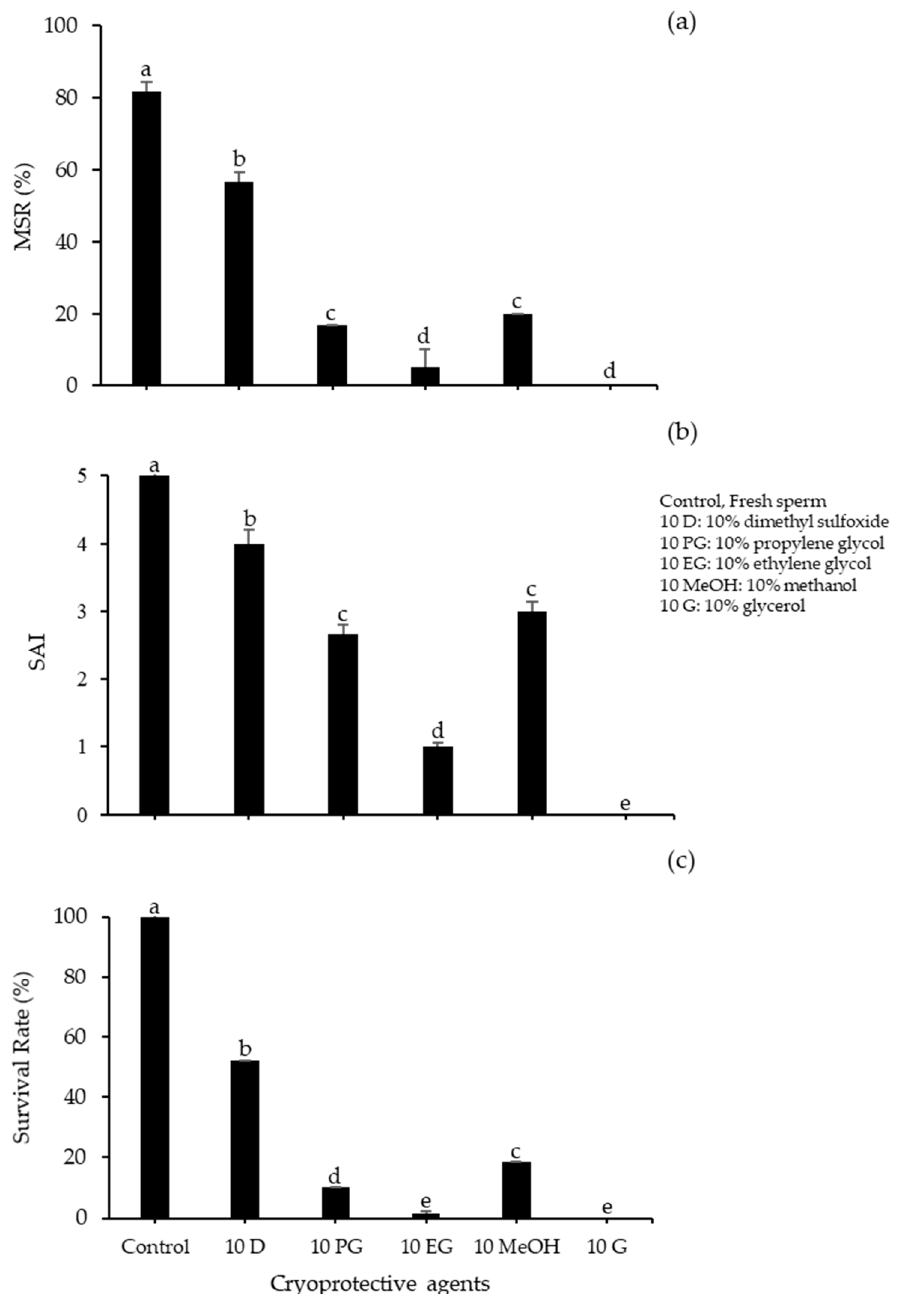
Figure 1. Performance of spotted halibut frozen–thawed sperm with 300 mM glucose at various cryoprotective agents (CPA)s: ( a ) movable sperm ratio (MSR); ( b ) sperm activity index (SAI); ( c ) survival rate. Significant differences between CPAs are indicated by the letters ( p < 0.05).